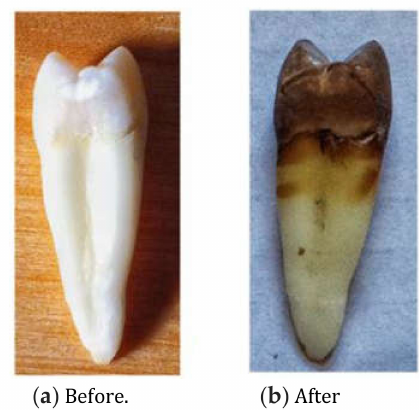
Figure 1. Color aspects of an extracted tooth before and after two weeks in a carbonated soft drink.